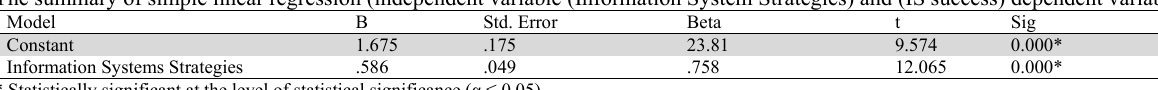
The summary of simple linear regression (independent variable (Information System Strategies) and (IS success) dependent variable)